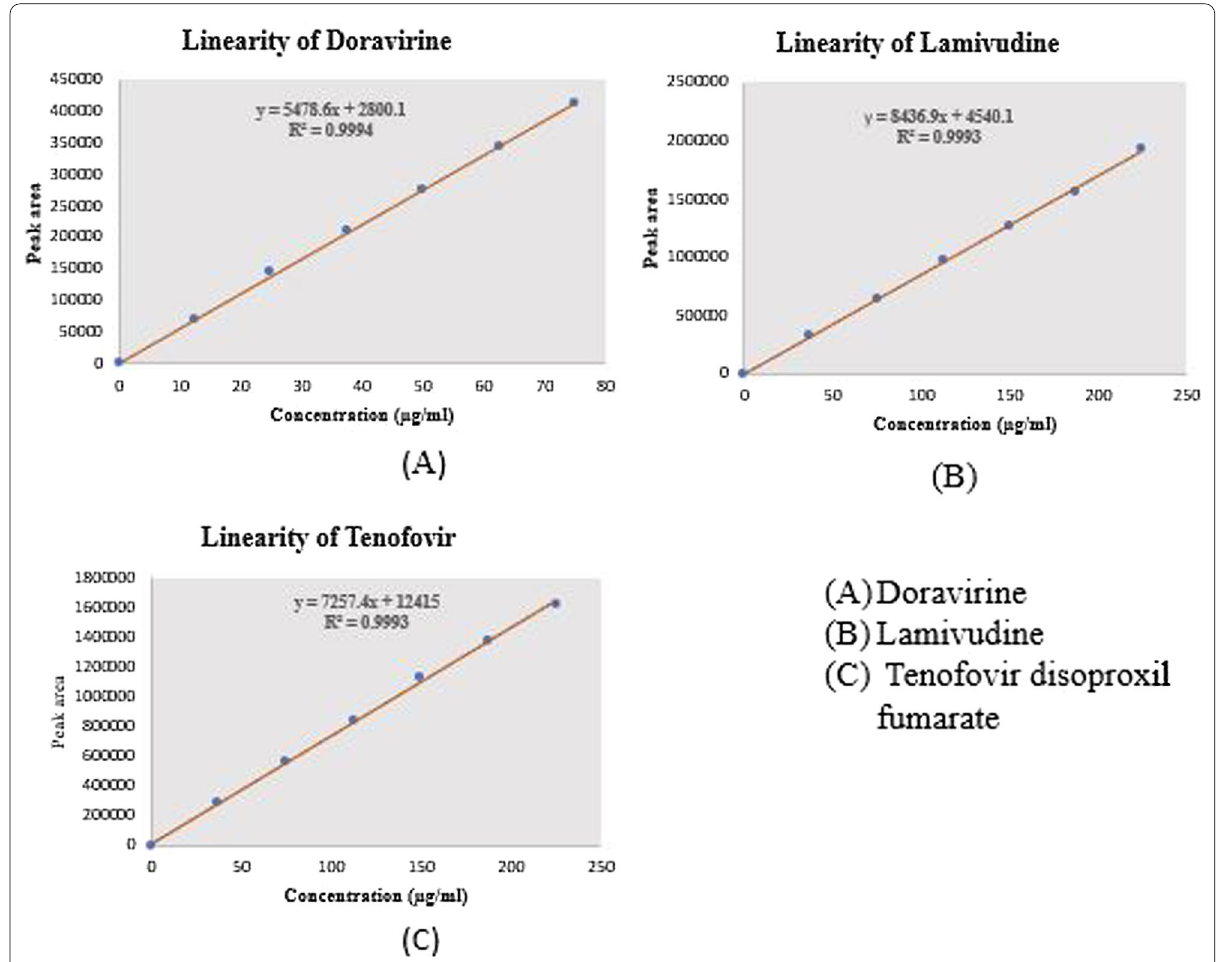
Fig. 2 Chromatogram of the standard